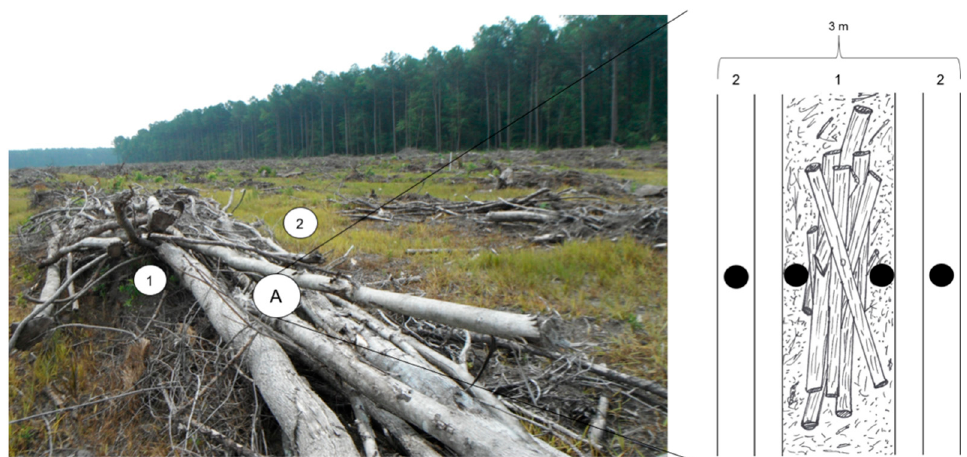
Figure 1. A harvest residue pile in a clear-cut stand two-years post-harvest in North Carolina. Stands consisted of uniformly dispersed interbeds containing harvest residues (1) and bedded rows containing planted pine seedlings (2). We set pitfall traps immediately adjacent to either side of harvest residues piles, when present, and two pitfall traps were situated in bedded rows on either side of the interbed (A). Photo by Sarah Fritts. Drawing by Steve Grodsky.